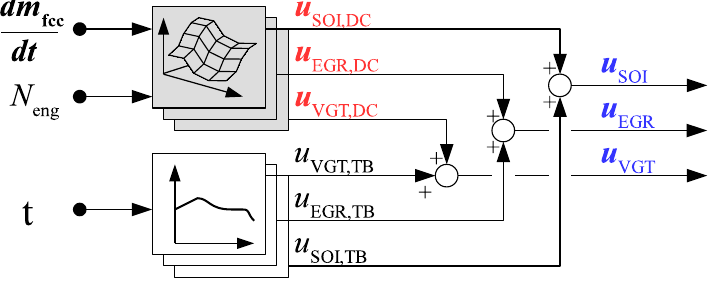
Figure 13. Time-based (TB) control of actuator set-points: compensation of the time-resolved reference values.